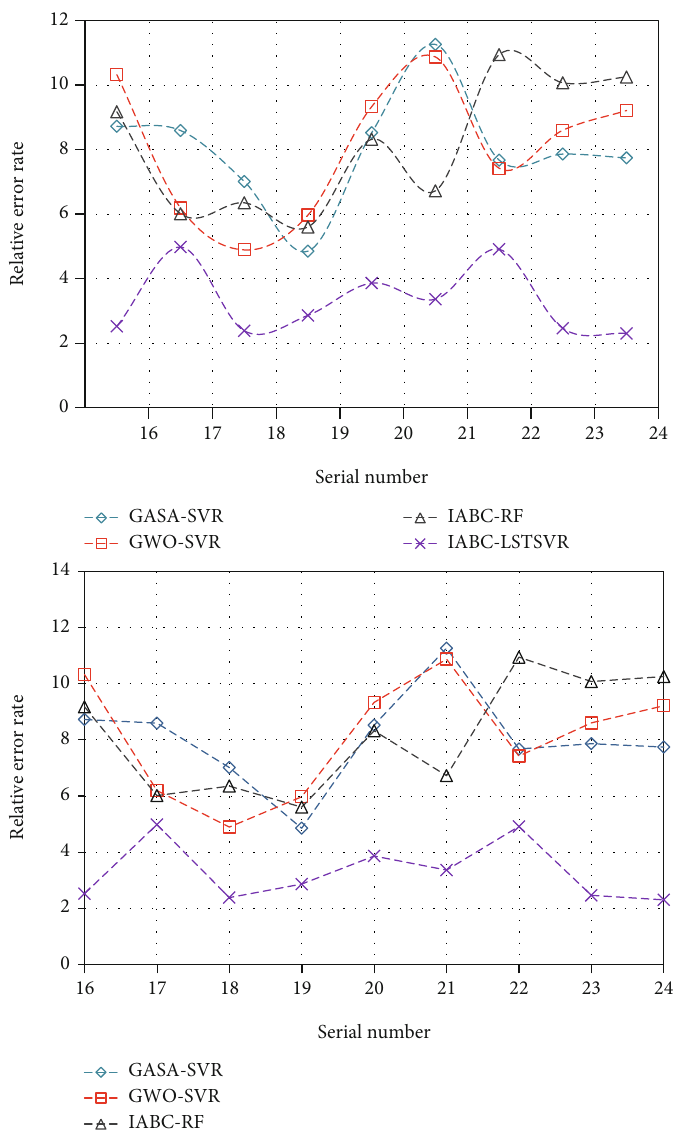
Figure 10: Relative error rate comparison